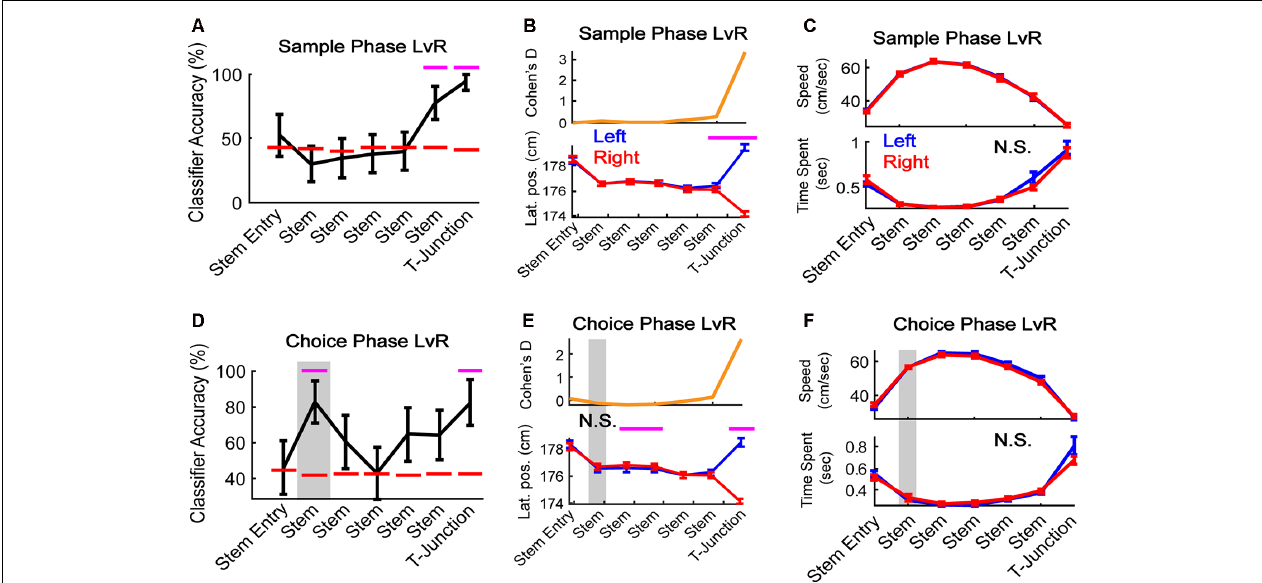
FIGURE 3 | mPFC population activity predicts a future decision. (A) During sample traversals, the mPFC population predicted trajectory (left vs. right turns) as rats approached and occupied T-junction (bin 6: Z = 2.0, p = 0.049; bin 7: Z = 2.9, p = 0.004). N = 187 neurons, six random trials were selected per class and neuron (see “Materials and Methods” section), 1,000 times. (B) Rats altered their lateral positions in a manner consistent with classification in panel (A) . There was a significant interaction between task phase and bin ( F (1,6) = 39.63, p = 1.3e-40). Bins 6 and 7 survived Bonferroni correction ( t (43) = 3.4, p = 0.001; t (43) = 31.3, p = 3.3e-31; Bonferroni corrected alpha = 0.007). N = 44 sessions. (C) Differences in time-spent at the T-junction and velocity do not account for the mPFC predicting the future trajectory. There was no main effect of trajectory ( F (1,6) = 0.08, p = 0.77) or interaction between sample left/right velocity and bin-location ( F (1,6) = 0.05, p = 0.99). N.S. indicates no significance. (D) During choice phase, the mPFC predicted the future (Stem bin 2: Z = 2.28, p = 0.023) and current (T-junction: Z = 2.2, p = 0.028) trajectory. For classification procedures: N = 187 neurons, six random trials were selected per class and neuron, 1,000 times. Magenta lines indicate p < 0.05 using a z -test against a shuffled distribution. Gray box highlights the second bin where the mPFC could predict the future left or right, and is used in the following panels. Data are represented as the mean ± standard deviation. (E) Lateral positions do not change in the stem location where the population predicts a future decision in panel (D) . There was a significant interaction between choice trajectory and stem bin ( F (1,6) = 27.6, p = 3.8e-29). Stem bins 3 and 4, and T-junction, survived Bonferroni correction ( t (43) = − 4.3, p = 0.0001, t (43) = − 3.5, p = 0.001, t (43) = 24.1, p = 1.2e-26; Bonferroni corrected alpha = 0.007). (F) There was no main effect of task phase nor interaction for choice left vs. choice right for velocity (top panel F (1,6) = 1.25, p = 0.26; F (1,6) = 0.97, p = 0.45) or time spent (bottom panel F (1,6) = 0.45, p = 0.5; F (1,6) = 1.86, p = 0.085. Gray box highlights the bin where classification accuracy was above chance. For behavioral analyses, data are represented as the mean ± SEM. Paired t -tests were performed, but only those that survived Bonferroni correction were plotted with magenta lines. N.S., not